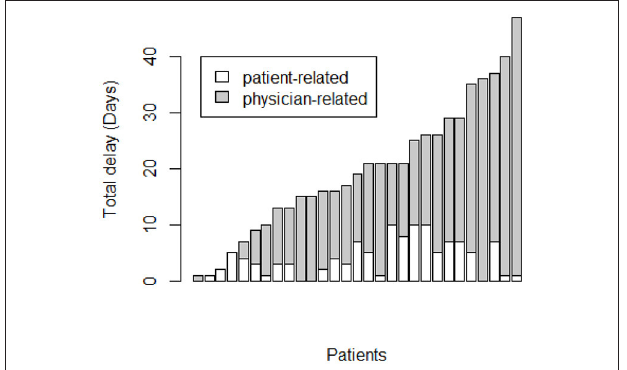
FIGURE 1 | Correlation between pulmonary embolism overall diagnostic delay (days) and physician-related delay.